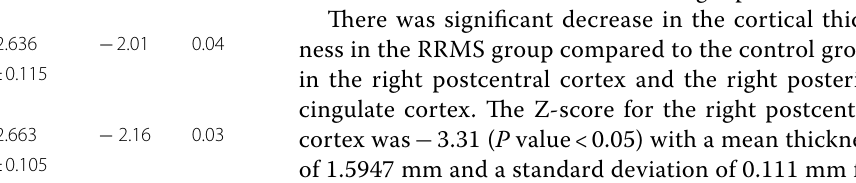
Table 2 Quantitative results of the mean cortical thickness in mm of the left and right hemisphere for patients and control groups, Z-scores and P values Mean cortical